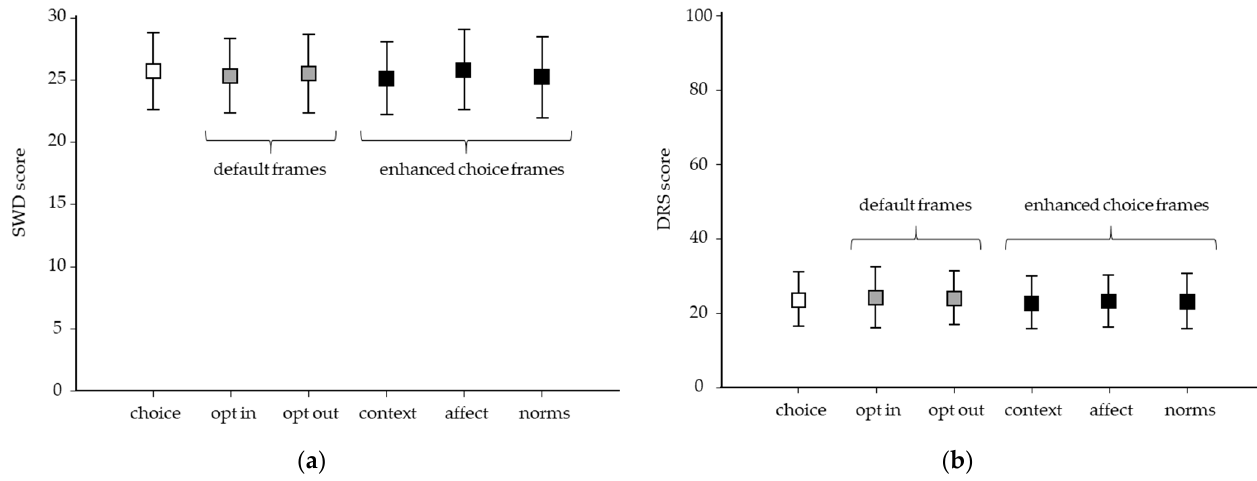
Figure 3. Satisfaction with decision and decision regret according to framing ( n = 1012). Satisfaction with decision (SWD) and decision regret (DRS). ( a ) SWD scores did not differ across frames (F = 1.353, p = 0.24). ( b ) DRS scores did not differ across decision frames (F = 0.875, p = 0.49). Boxes show mean scores ± one standard deviation (error bars). White = choice, gray = default frames (opt-in, opt-out), and black = enhanced choice (context/consequence, affect/commitments, norms). Table 2. Theory of planned behavior decision cognition predictors of satisfaction with decision and decision regret. Theory of Planned Behavior